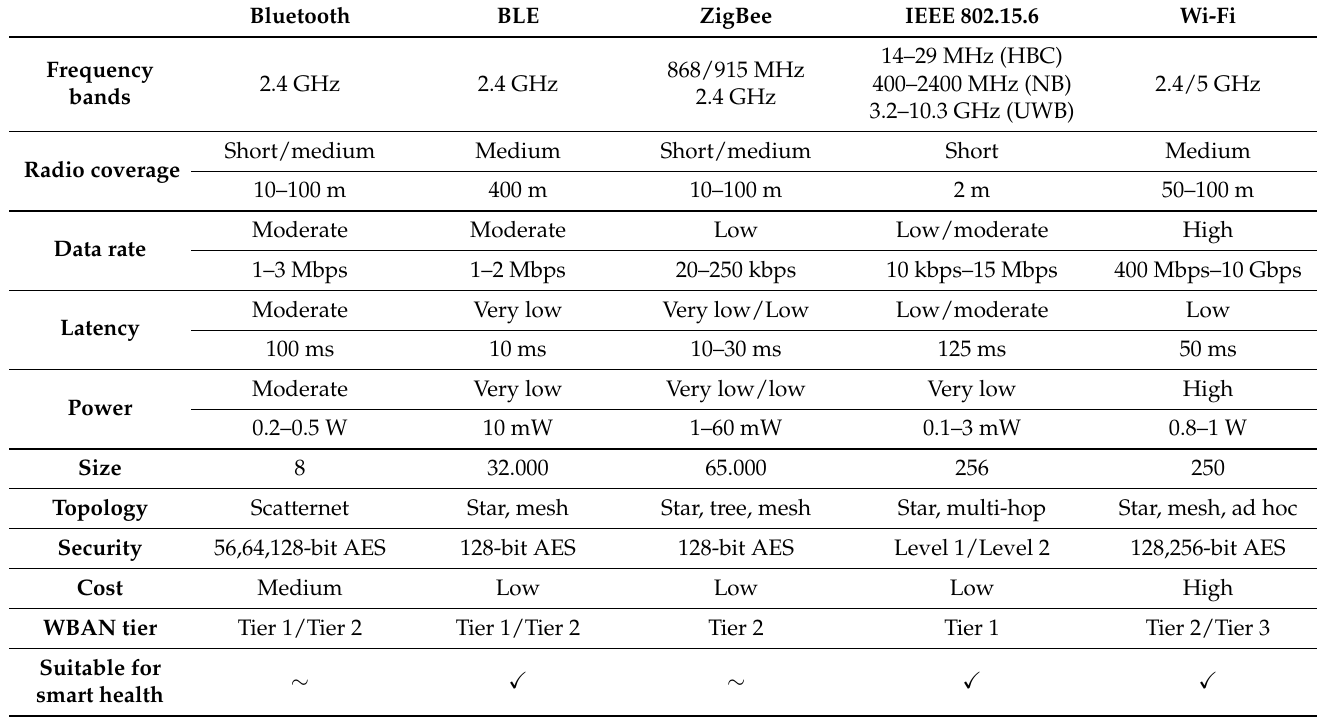
Table 11. Comparison of the main wireless communication technologies for smart healthcare